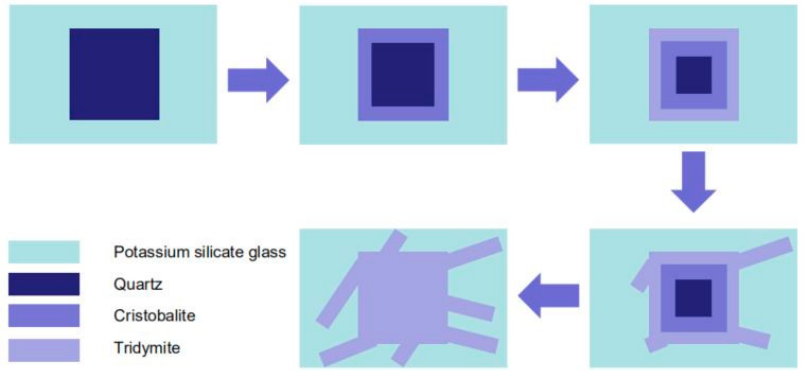
Figure 12. Schematic illustration of phase transformation of quartz-potassium silicate glass compo-